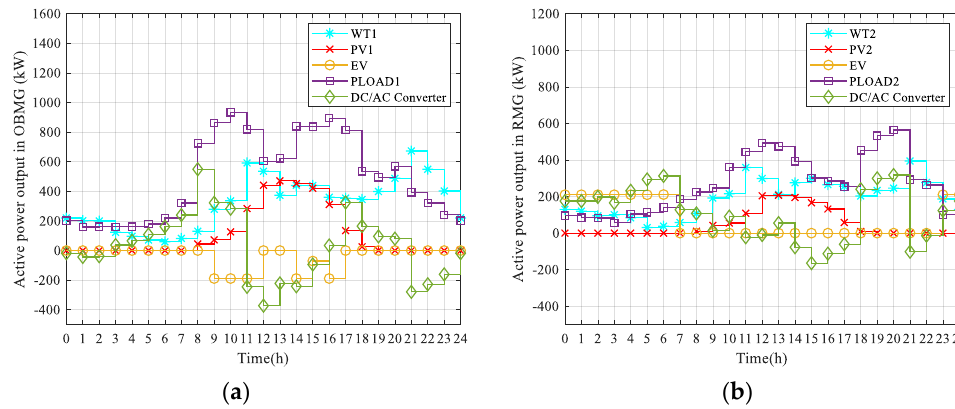
Figure 10. ( a ) Power output of RESs, EVs, and the DC/AC converter in OBMG; ( b ) power output of RESs, EVs, and the